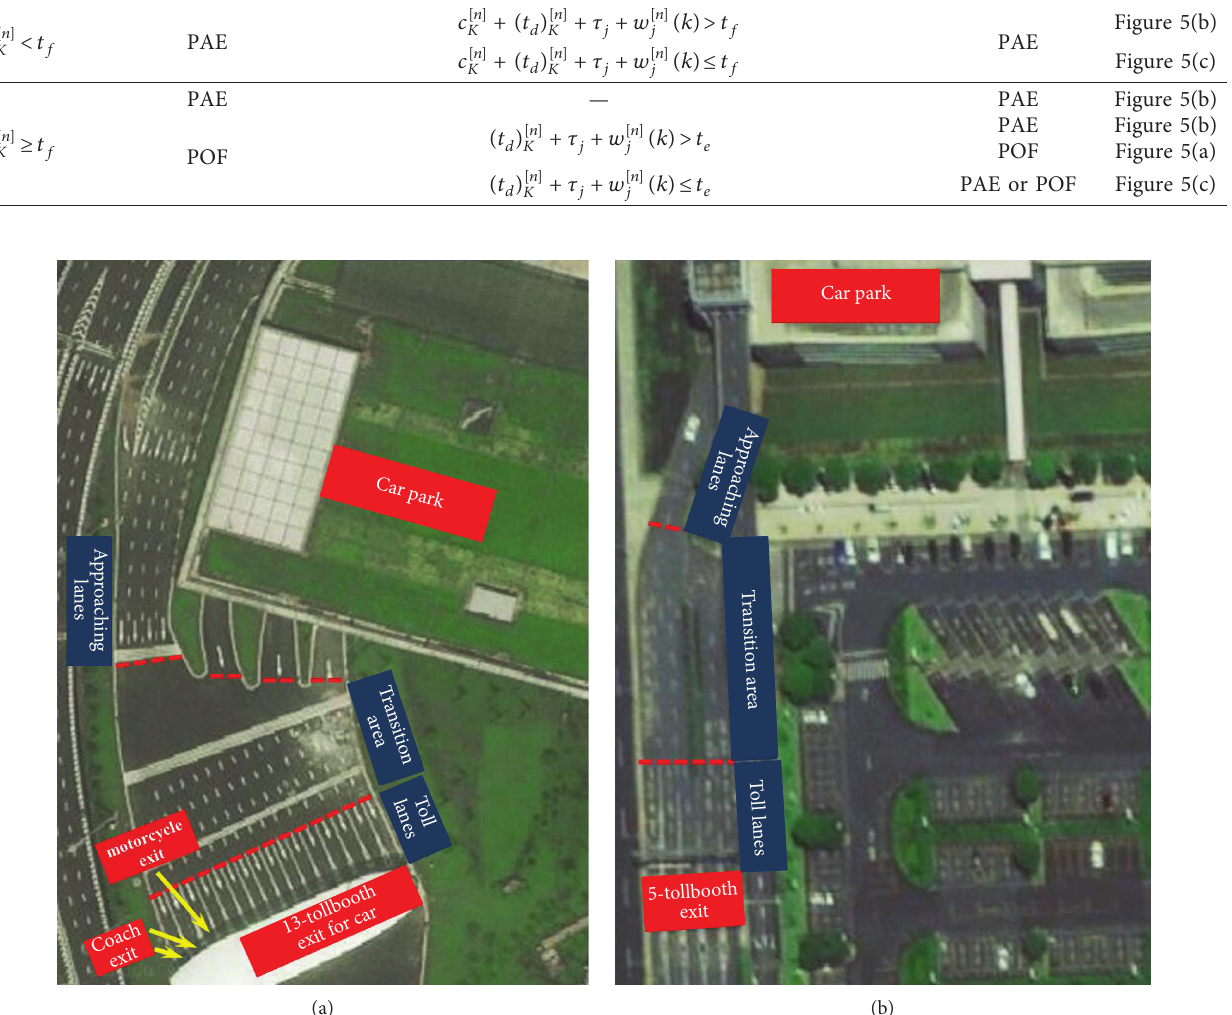
Figure 6: Two car parks for data sources. (a) Car park for Terminal 3A of Chongqing Jiangbei International Airport. (b) P7 car park for Shanghai Hongqiao International